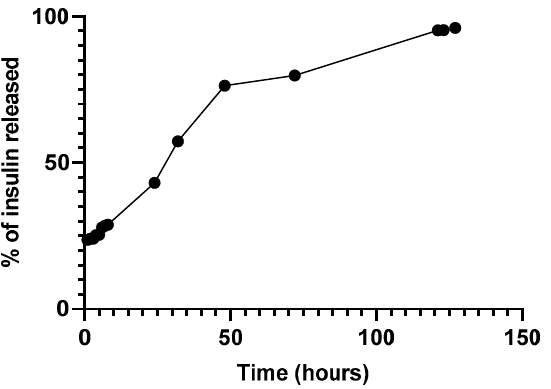
Figure 8. Release of insulin-loaded NPs through a Float-a-Lyzer at 37 °C in PBS pH 7.4.